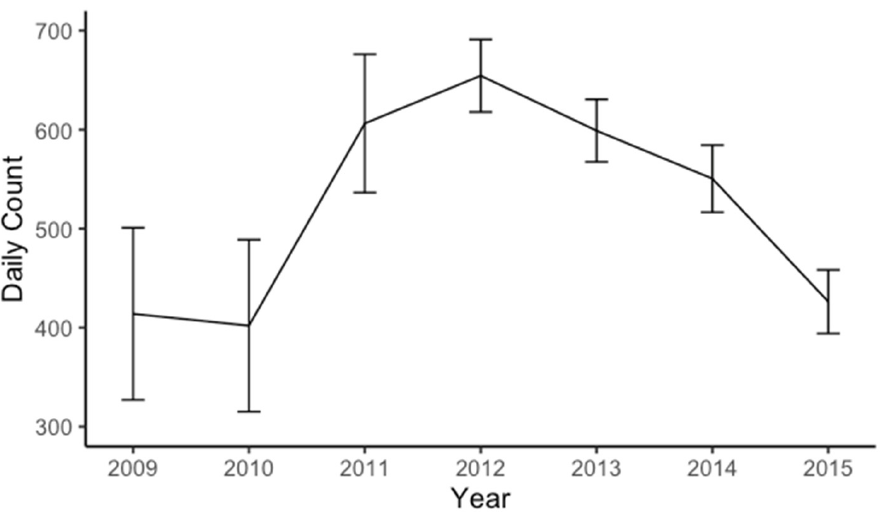
Figure 6. Daily total count of resident, non-migratory geese in the Anacostia restored tidal wetlands censused in the years of 2009 to 2015. Error bars are standard error.